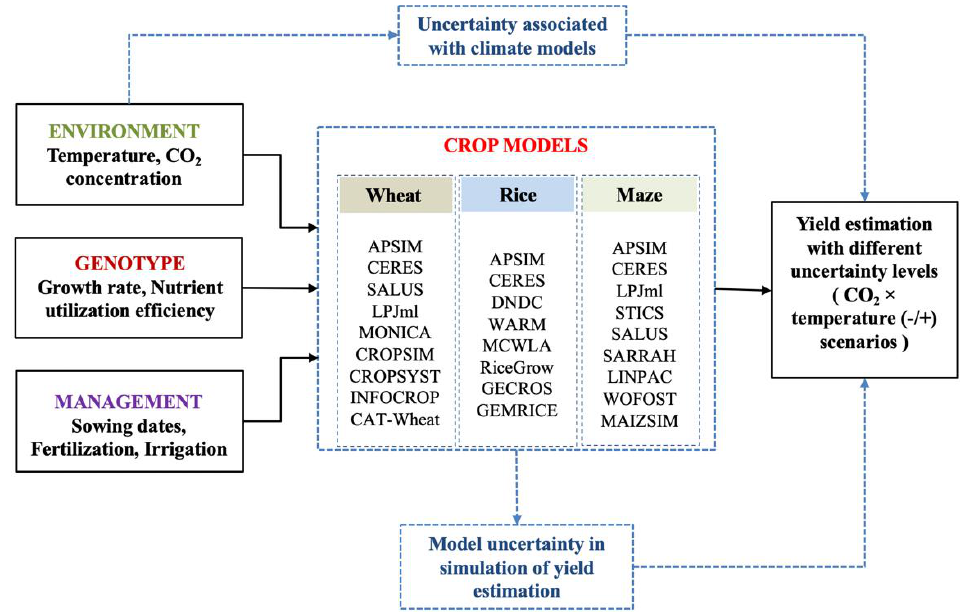
Figure 1. Crop model simulation framework with different sources of uncertainty affecting model predictions. Note: Further details of crop models are detailed in previous studies [3 – 8].